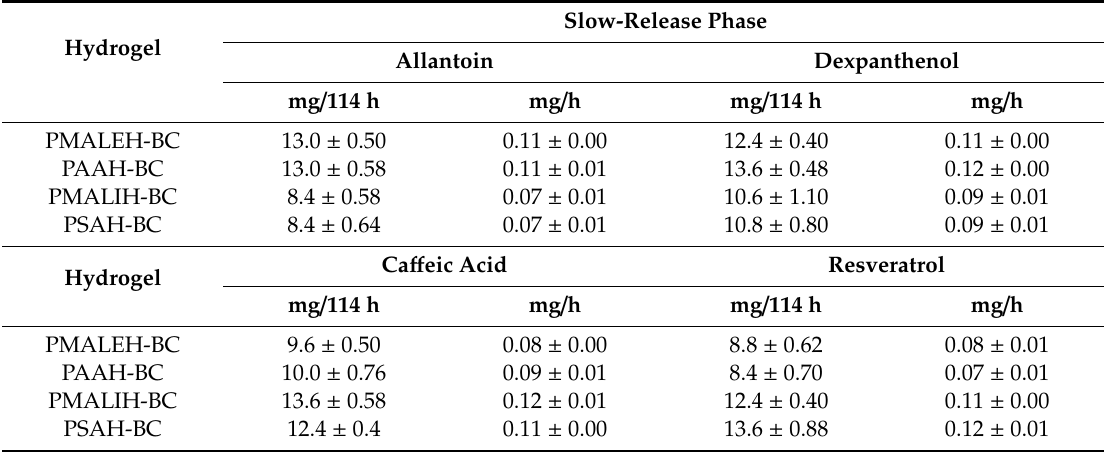
Table 5. The average release rate during the slow-release